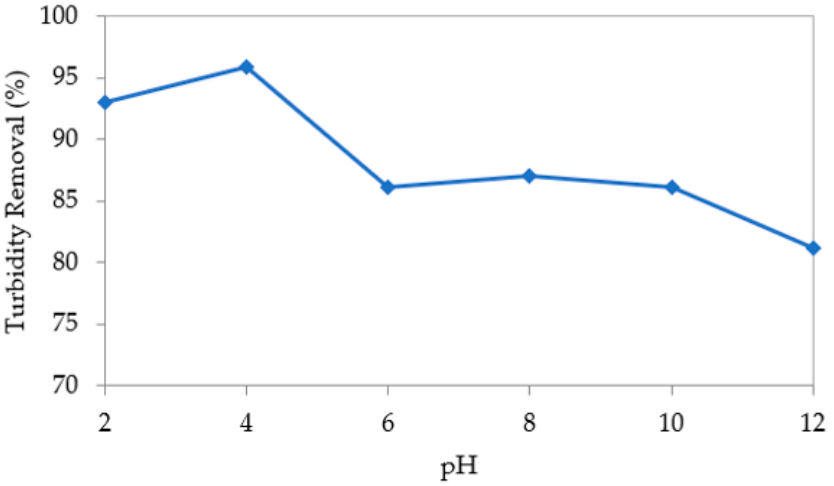
Figure 7. Turbidity removal using extracted bagasse as a natural coagulant on different pH at constant dosage of 50 mg/L.